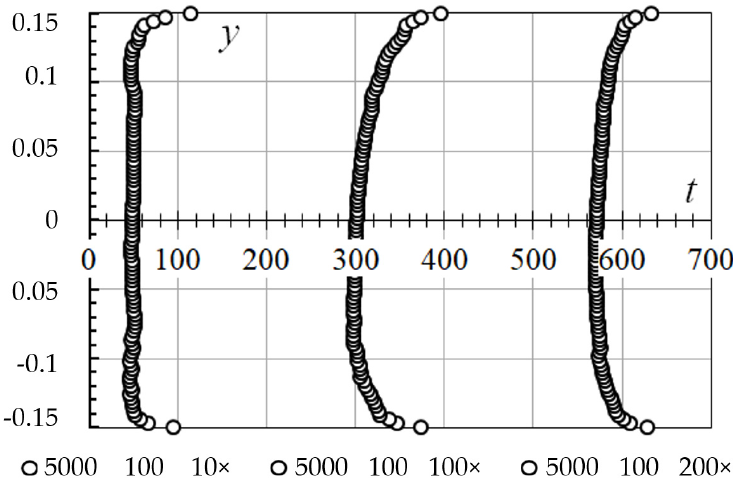
Figure 5. Air temperature profiles in the vertical central-section ZOY, 100 kg/h ( t [°C], y [m]), curves from left to right, respectively: 10×; 100×; 200×.